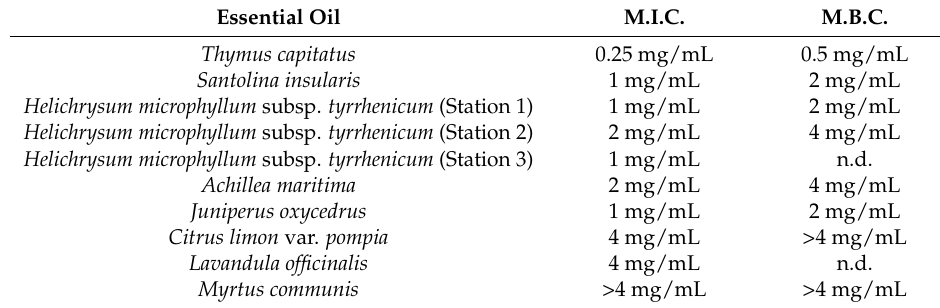
Table 2. Minimum inhibitory concentration (M.I.C.) and minimum bactericidal